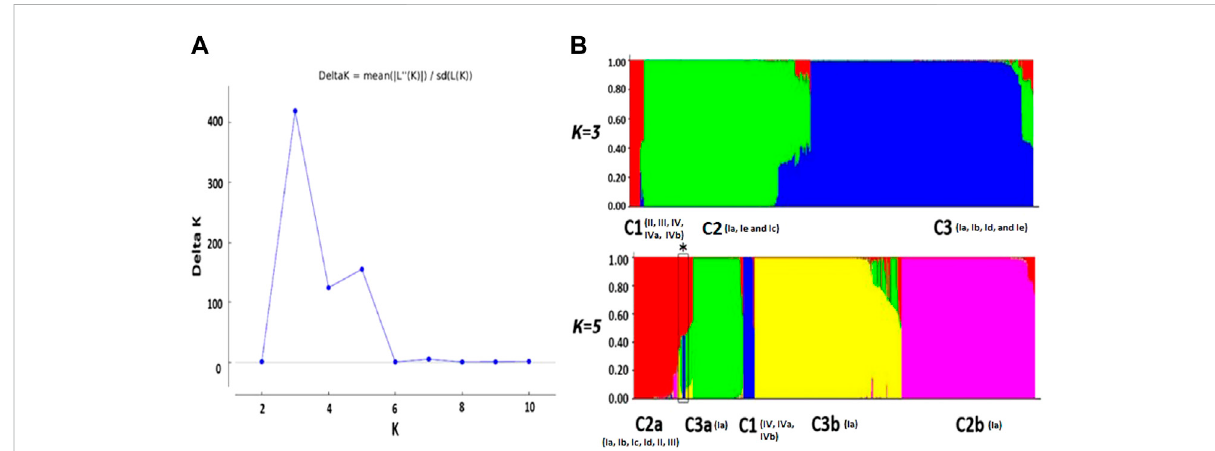
FIGURE 1 Bayesian structure analysis. (A) Plot K vs. Δ K shows the optimum number of subpopulations. K represents the number of clusters. The plot representsthe fi rstmajorpeakatK=3,followedbytheminorpeakatK=5 (B) .ThecolorbarplotsshowthegeneticstructureofVHSVatK=3andK= 5 using the admixture model of the STRUCTURE resource. The number in brackets represents genotypes. At K = 3, C1 comprised samples from genotypes II, III, IV, IVa, and IVb. C2 includes genotypes Ia, Ie, and Ic isolated from Denmark, while the genotype Ia samples isolated from other European countries along with genotypes Ib, Id, and Ie are grouped into C3. At K = 5, there are C2a (comprised genotypes Ia, Ib, Ic, Id, II, and III), C3a (genotype Ia), C1 (genotypes IV, IVa, and IVb), C3b (genotype Ia), and C2b (genotype Ia) clusters. Admixed strains were also found in C2a and C3a showing multiple membership scores (marked with a box and